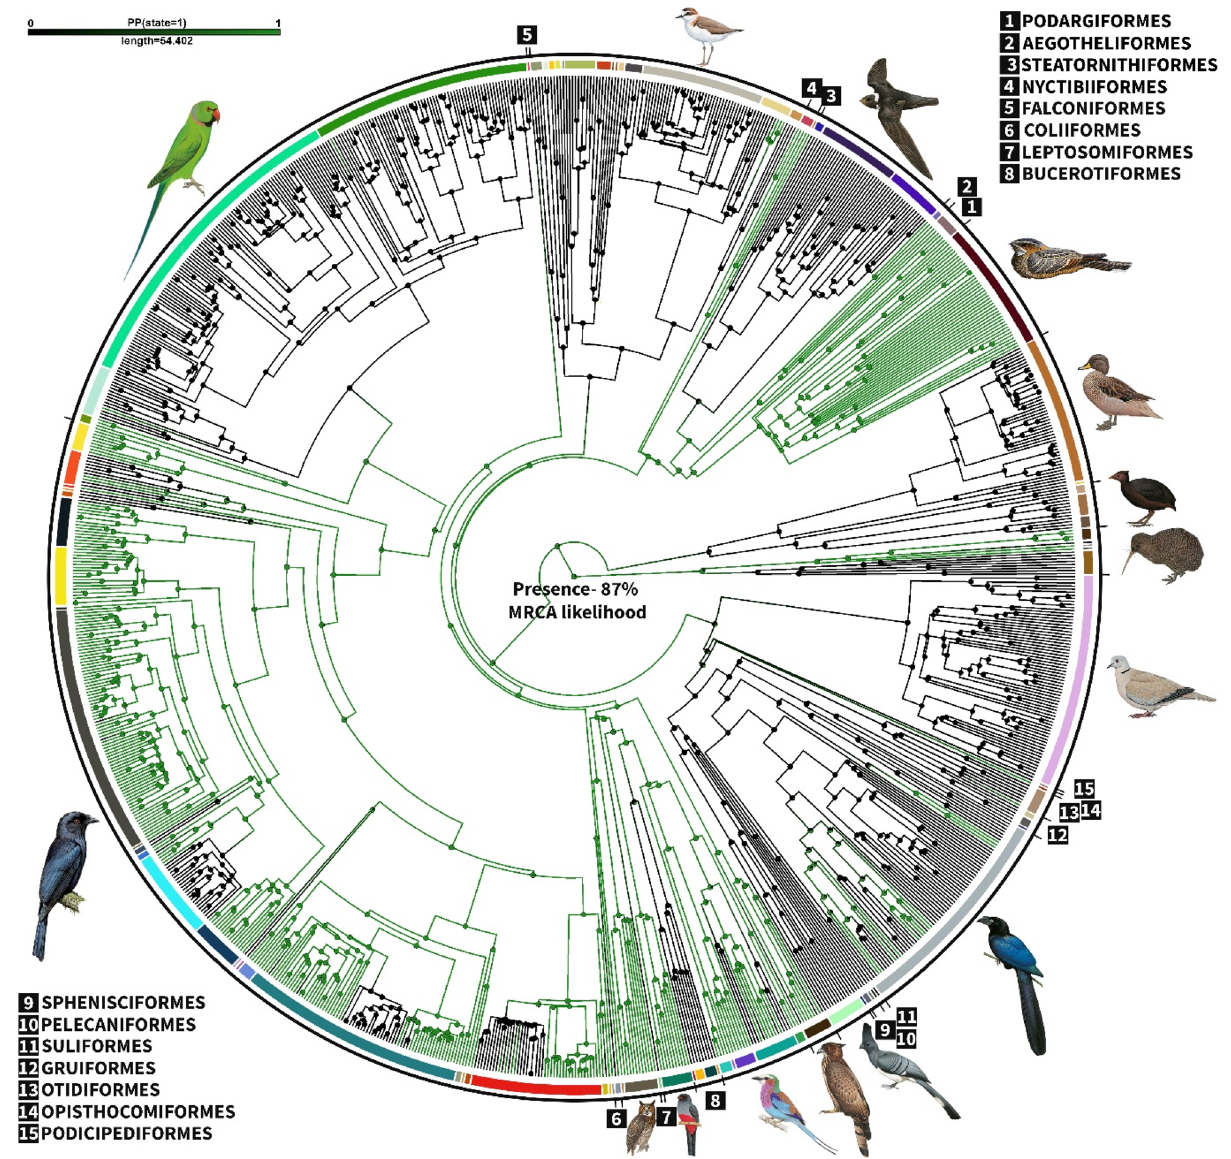
Figure 3. Phylogenetic trees mapping the ancestral character estimation for the presence of rictal bristles. Terminal branches correspond with the different species measured. The colour of the branches in the tree gives the posterior probability of the rictal bristle character through avian evolution; black indicates a high probability of rictal bristle absence while green indicates the presence of rictal bristles. The inner coloured arc encircling the radial phylogenetic tree illustrates the different avian families to which each species belongs, and the black outer circle corresponds to avian